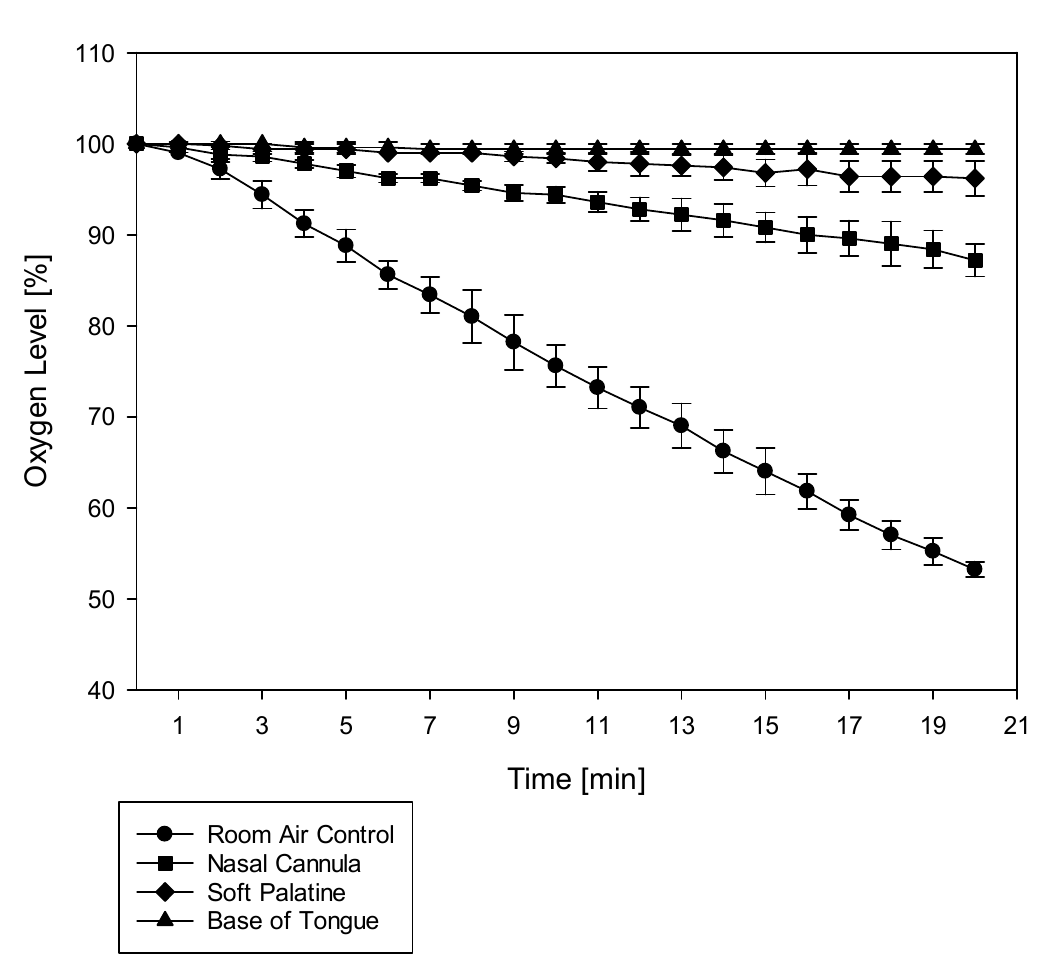
Figure 1. Course of oxygen content in the test lung for an observation period of 20 min ( p = 0.003 for soft palatine vs. base of tongue and p < 0.001 for all other groups).